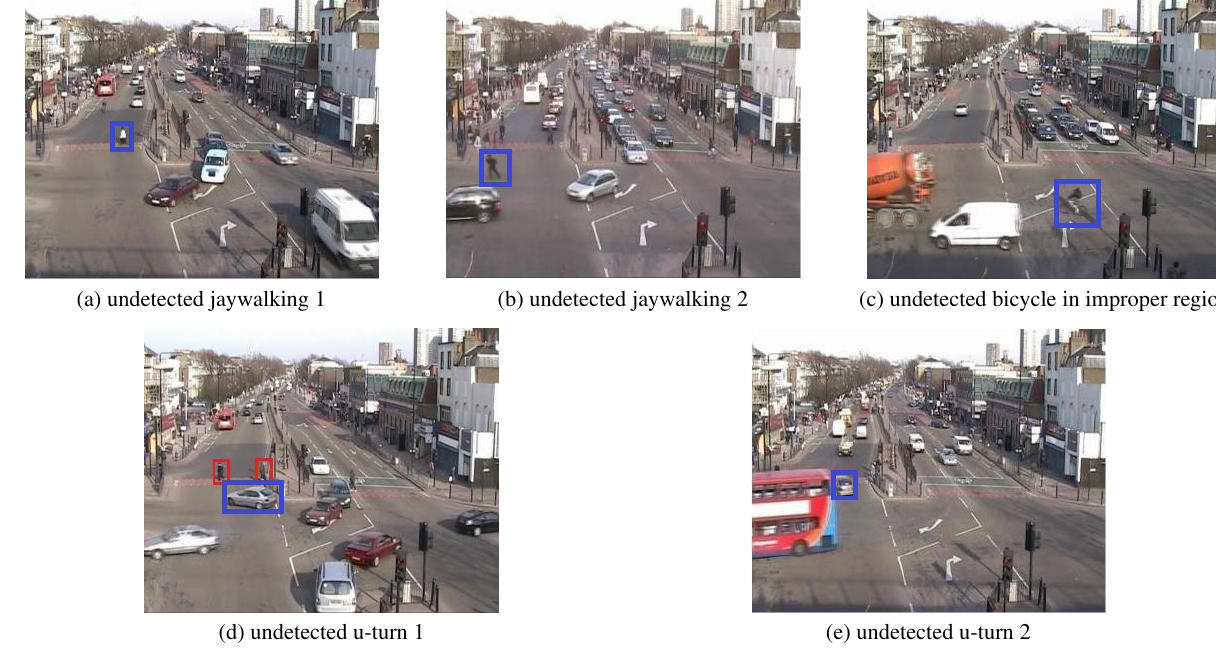
Figure 5: Examples of undetected anomaly using our GP models (the key abnormal object is highlighted with a